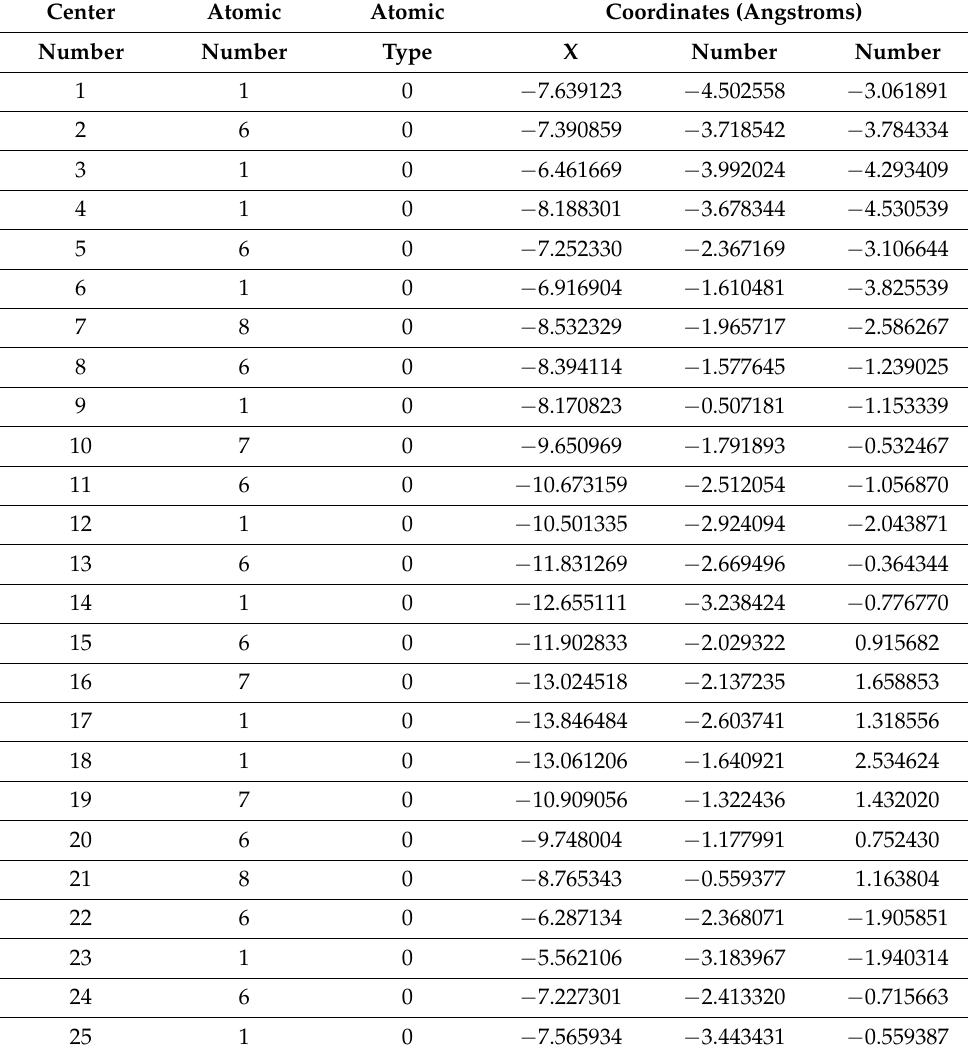
Table A13. Complex MgI 3 LiII 2 with nucleotide triplet